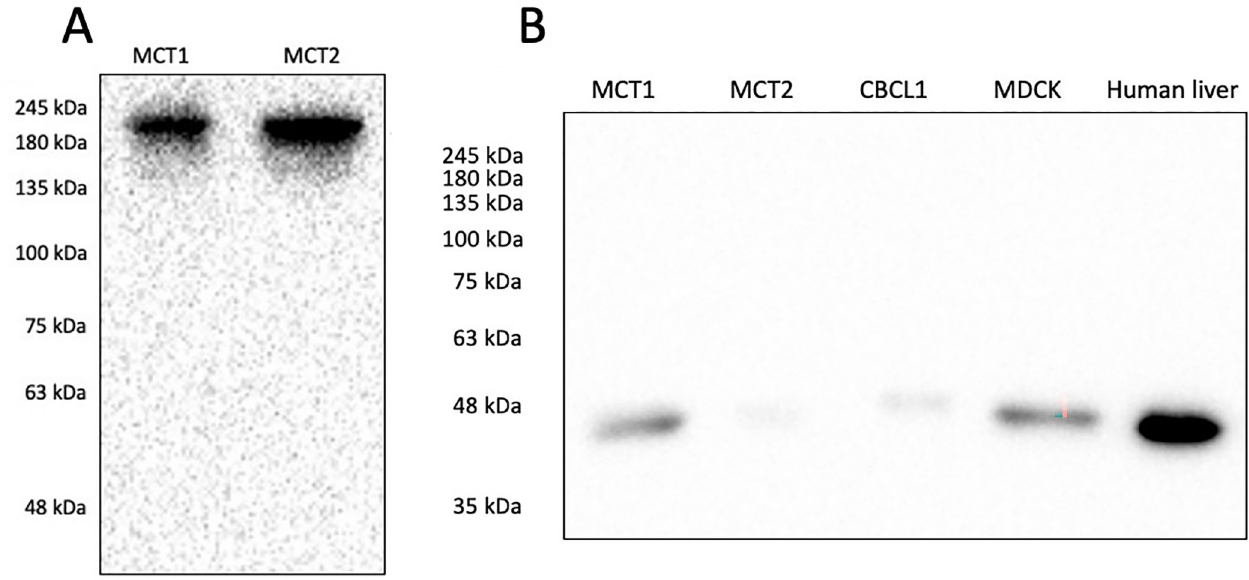
Fig 1. Western blots showing validation of antibodies used for immunohistochemistry. A ) DNMT1: predicted molecular mass 183 kDa; B ) IDH1: predicted molecular mass 47 kDa. MCT1, MCT2: canine mast cell cancer cell line lysates; CLBL1: canine B-cell lymphoma cell line lysate; MDCK: Madin-Darby canine kidney cell line lysate; Human liver: commercially available lysate for western